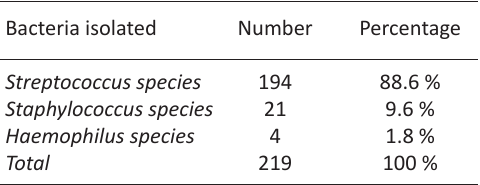
Table 1. species of bacteria isolated from patients with acute suppurative tonsillitis.